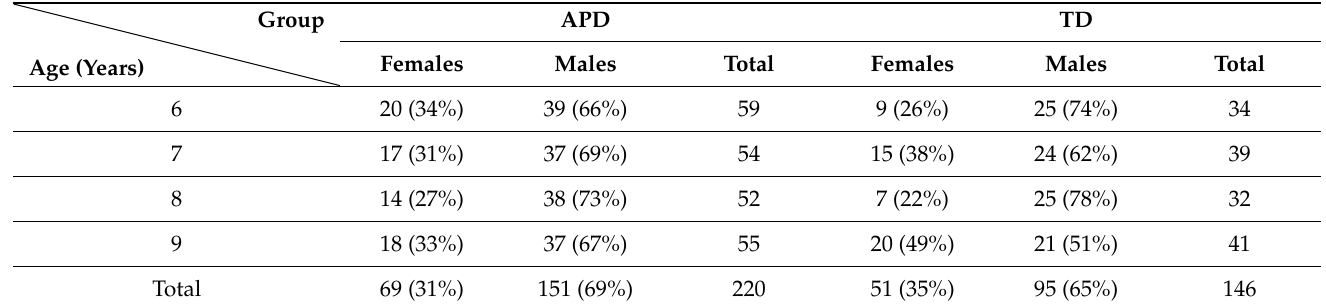
Table 1. Auditory processing disorder (APD) and typically developing (TD) groups: sex distribution by